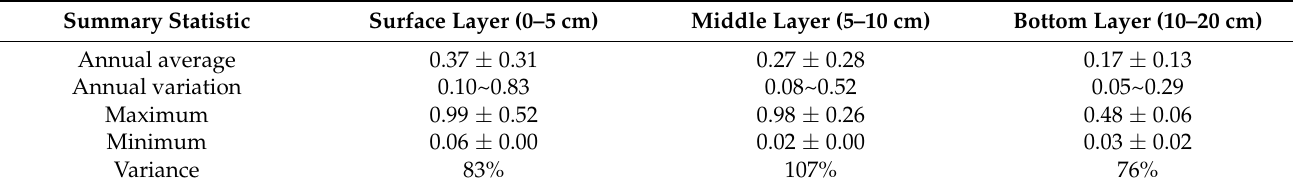
Table 2. Annual variation in soluble-P in sediment of Dianchi Lake (P mg kg − 1